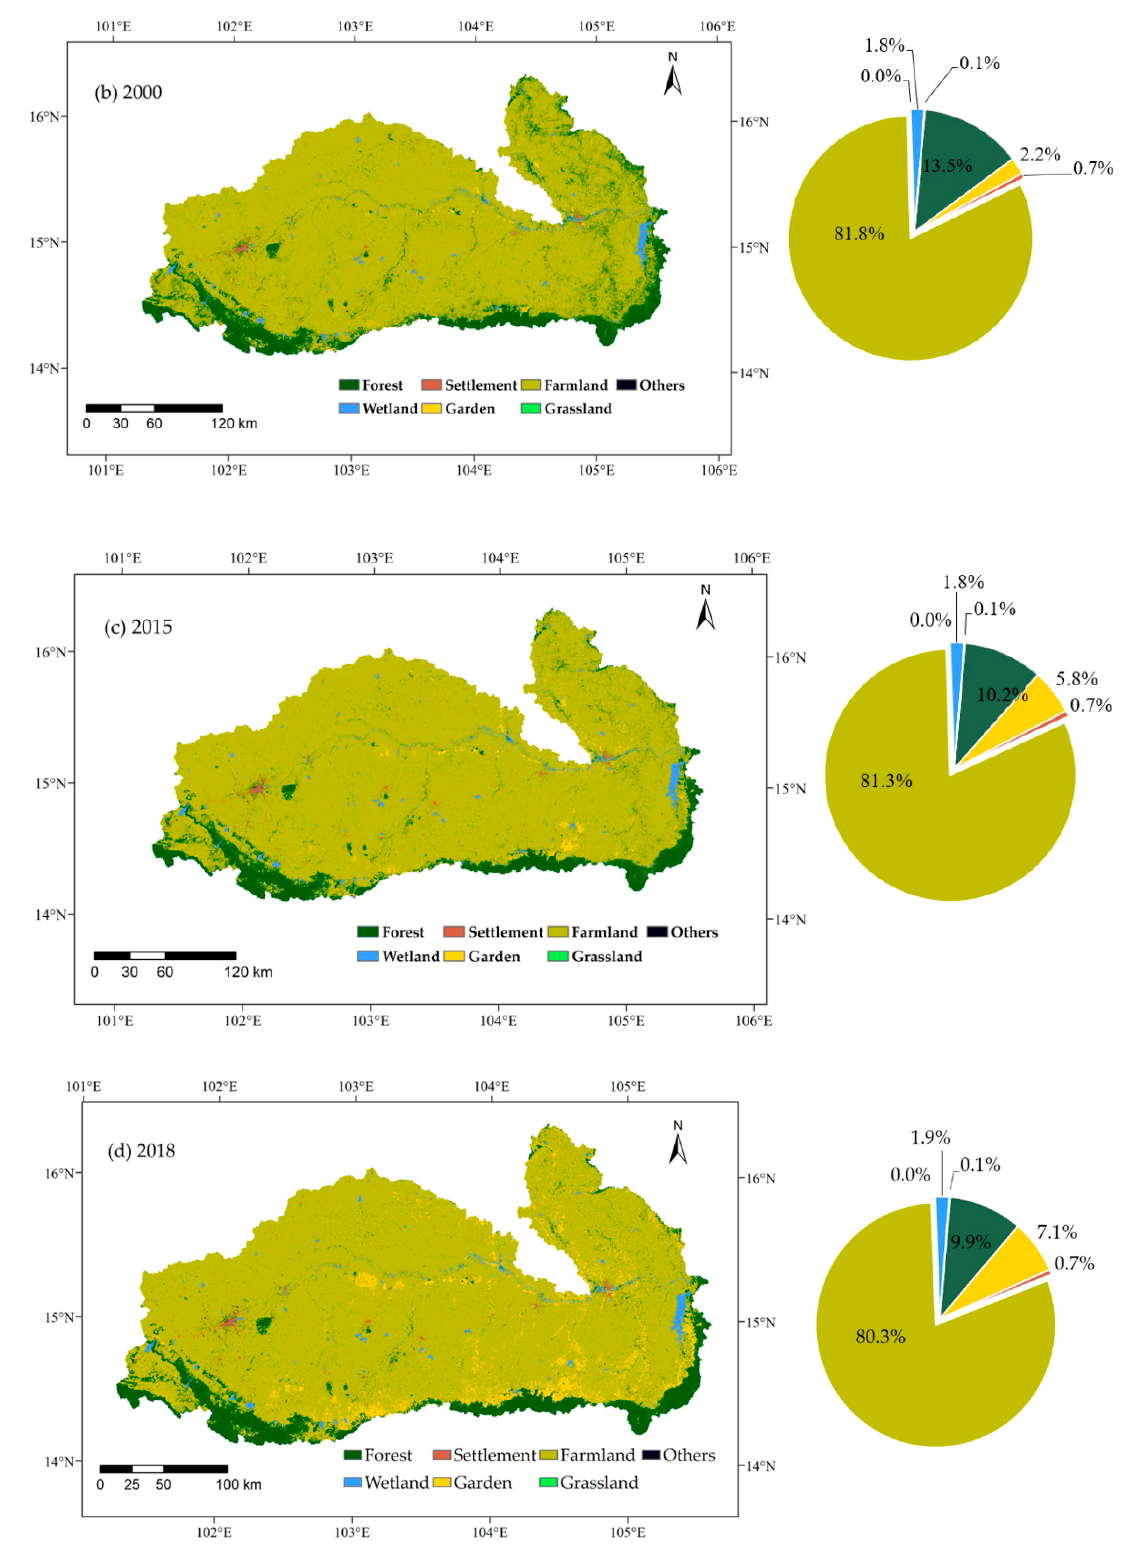
Figure 10. The distribution maps of different land use types in 1987 ( a ), 2000 ( b ), 2015 ( c ) and 2018 ( d ) in the Mun River basin